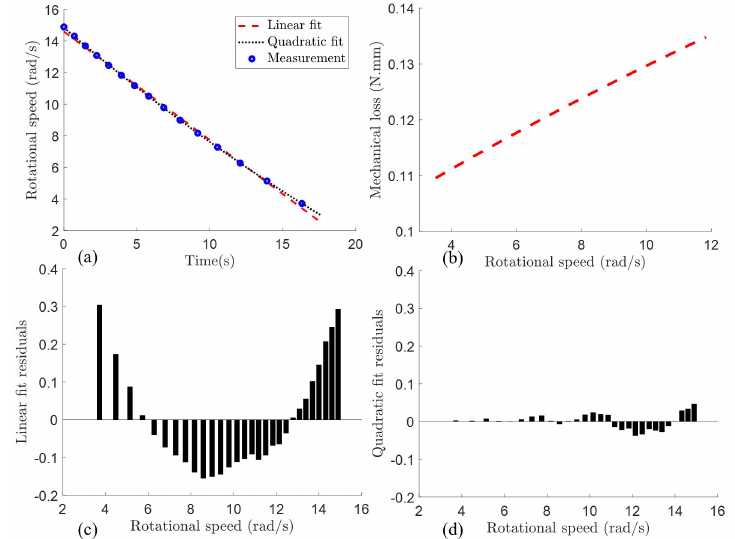
Figure 6. ( a ) An example of the deceleration curve with one inertia disk on the single tower apparatus with linear and quadratic fitted curves. ( b ) The post-processed mechanical loss curve as a function of the system rotating speed. Fitting deviation from the measured data with a linear fit ( c ) and a quadratic fit ( d ). To be clearly displayed only one every ten data points in ( a ) and one every five data points in ( c ) and ( d ) are being